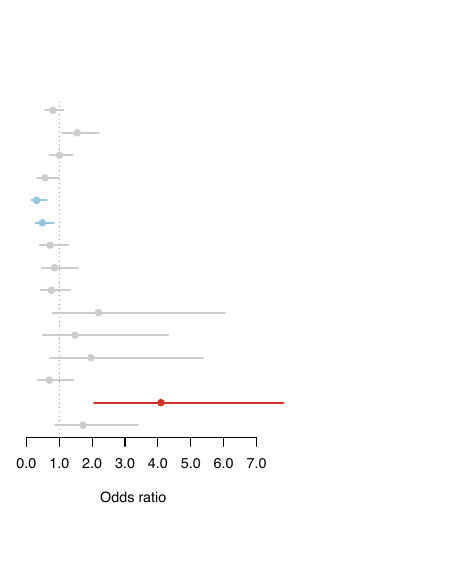
Fig. 6 | Odds ratios for relative E. coli invasiveness. The odds ratios (OR) for invasivenessaredisplayedwiththe95%con fi denceintervalcentredontheOR.The con fi dence intervals with a statistically signi fi cant ( p <0.05, two-tailed Pearson ’ s chi-squared test with Benjamini-Hochberg adjustment for multiple testing) lower bounds greater than 1 correspond to more invasive lineages (coloured red; OR statistically signi fi cantly higher than 1), and con fi dence intervals with a statistically signi fi cant upper bound <1 to more commensal lineages (coloured light blue; OR statistically signi fi cantly <1). Lineages with a con fi dence interval that contains the value 1, or are not statistically signi fi cantly different from 1, are labelled as